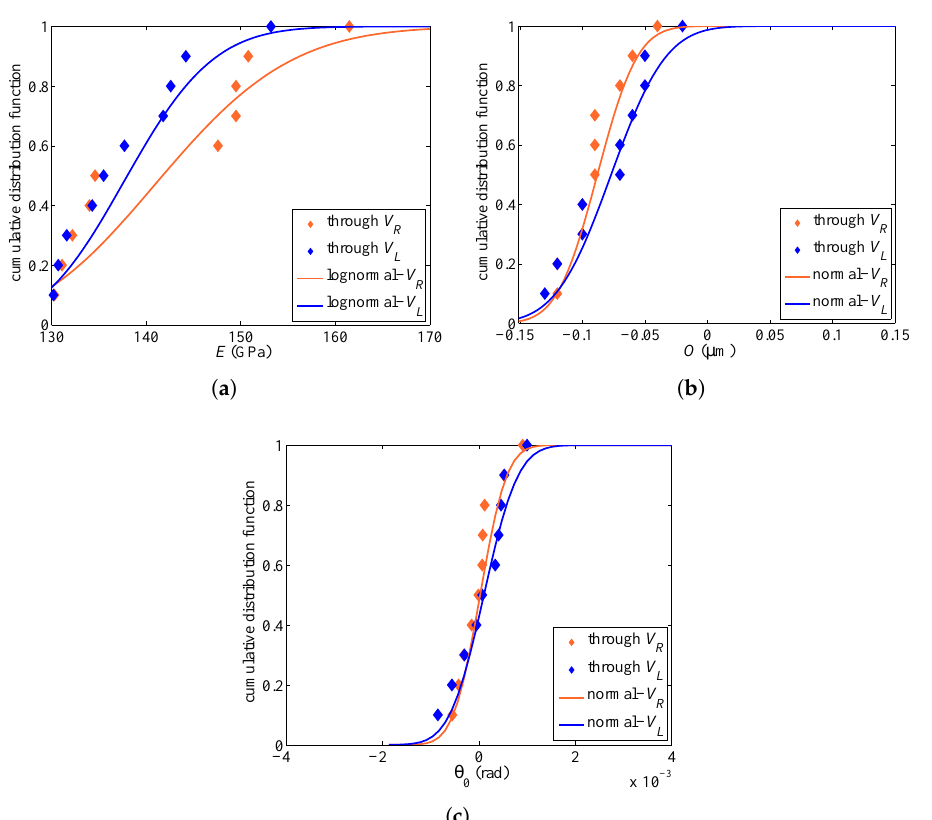
Figure 9. Cumulative distribution functions of model parameters ( a ) E , ( b ) O and ( c ) θ 0 estimated by the GA under either lateral or rotational actuation, and relevant fitting